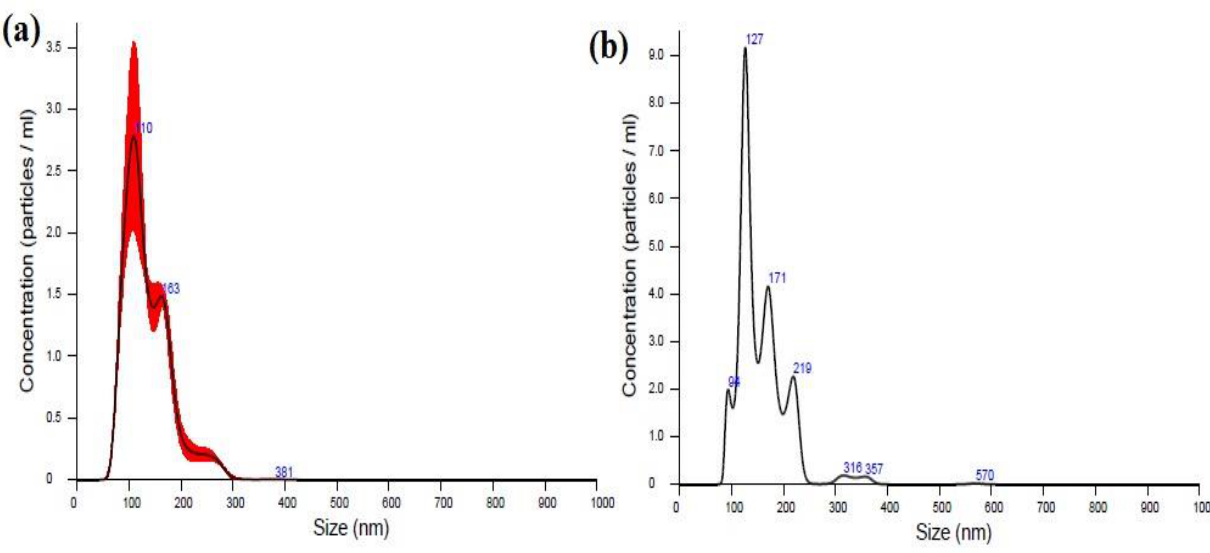
Figure 1. Nanoparticle tracking analysis of ( a ) THC-SLNs and ( b ) blank SLNs.